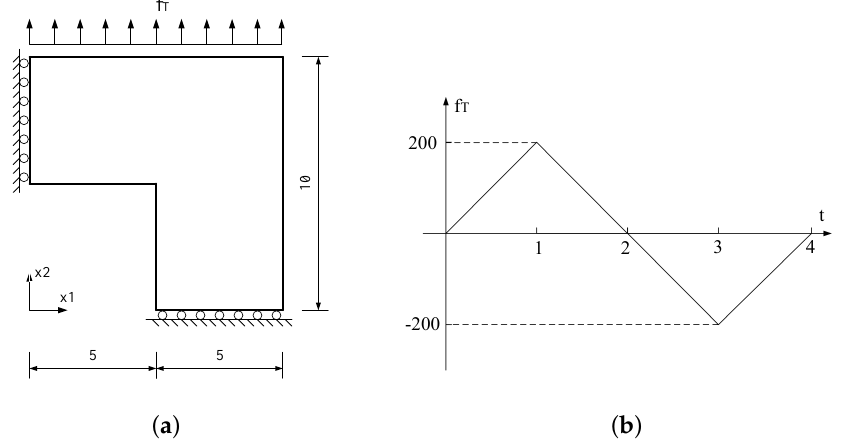
Figure 6. ( a ) Simplified 2D geometry of the elastic-plastic problem and ( b ) history of the traction force.